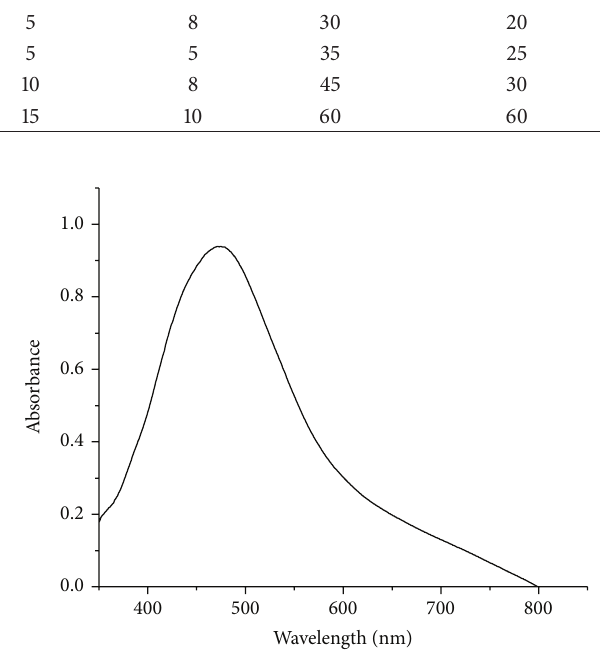
Figure 1: UV-Visible spectrum of Au nanoparticles, using ethylene glycolasasolventaswellasareducingagentattemperatureof298 K.